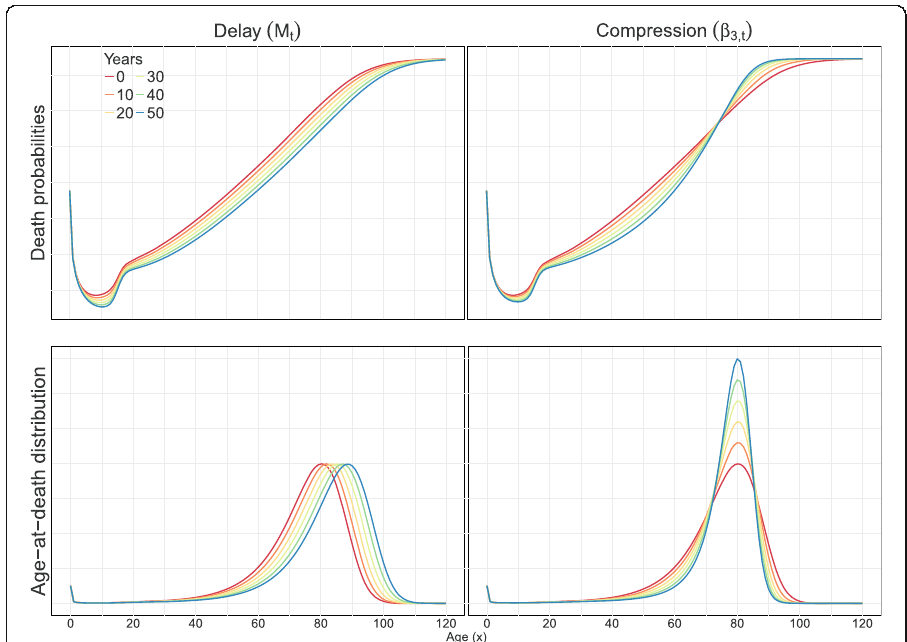
Fig. 1 The impact of increases in the modal age at death M t (i.e., delay) and of increases in β 3, t (i.e., compression) on the death probabilities and the age-at-death distribution. (We assume an increase of modal age by 2 months per year and a 5% increase of the compression parameter per 10 years. The values for year zero are chosen such that we observe the well-known mortality pattern by